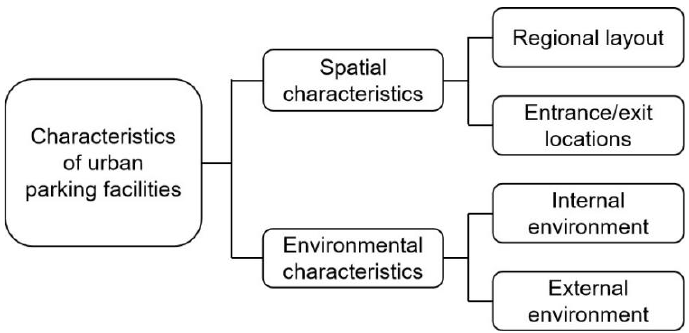
Figure 12. Connotation of urban parking facilities features in Yuzhong District.